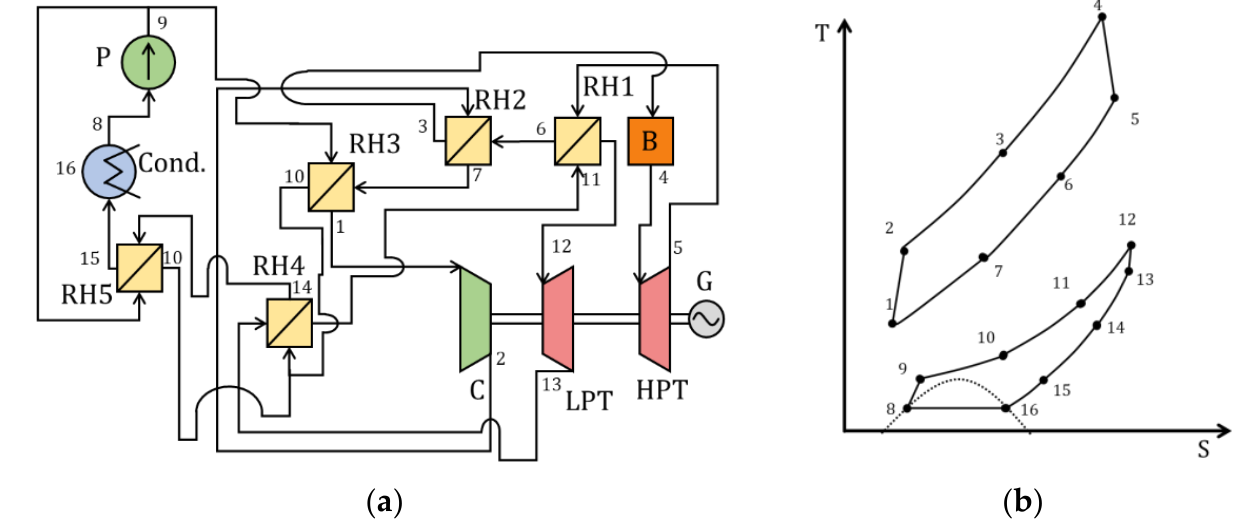
Figure 1. Cycle proposed by Gokhshtein and Verkhivker: ( a ) schematic diagram; ( b ) T–S diagram [11]. B—boiler; LPT—low-pressure turbine; HPT—high-pressure turbine; G—generator; Cond.—condenser; P—pump; RH1, RH2, RH3, RH4, RH5—regenerative heat